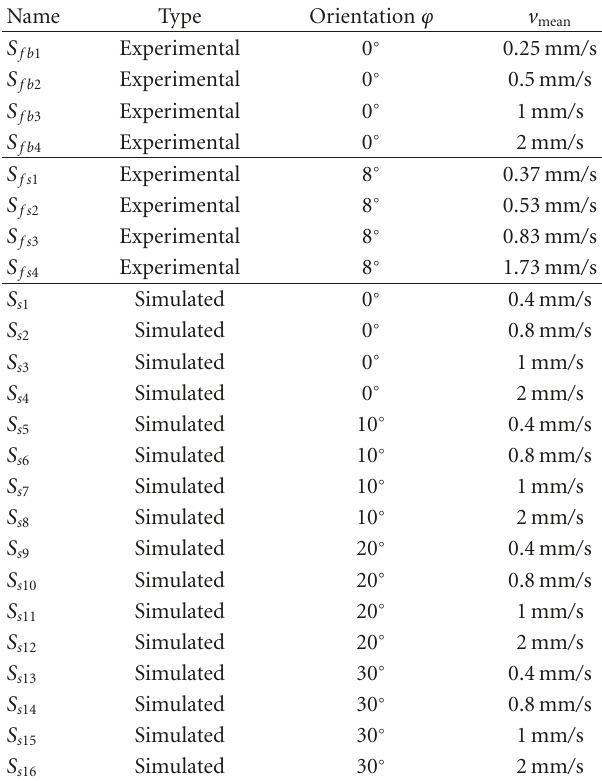
Table 1: List of the flow sequences used for the